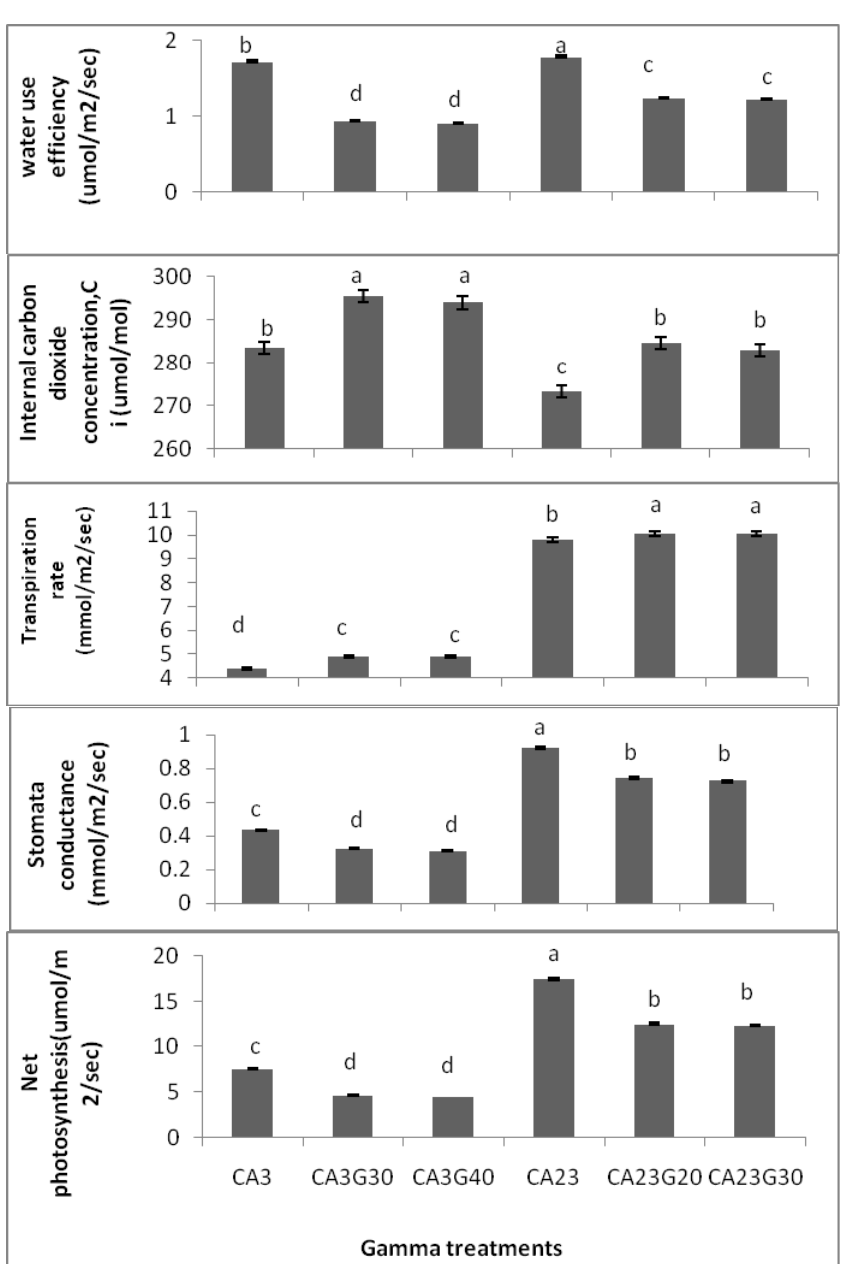
Figure 3. Effects of gamma irradiation on leaf gas exchange and WUE of irradiated and non irradiated accessions n = 4 (CA03G30 = CA03 irradiated to 30 Gy; CA03G40 = CA03 irradiated to 40 Gy; CA23G20 = CA23 irradiated to 20 Gy; CA23G30 = CA23 irradiated to 30